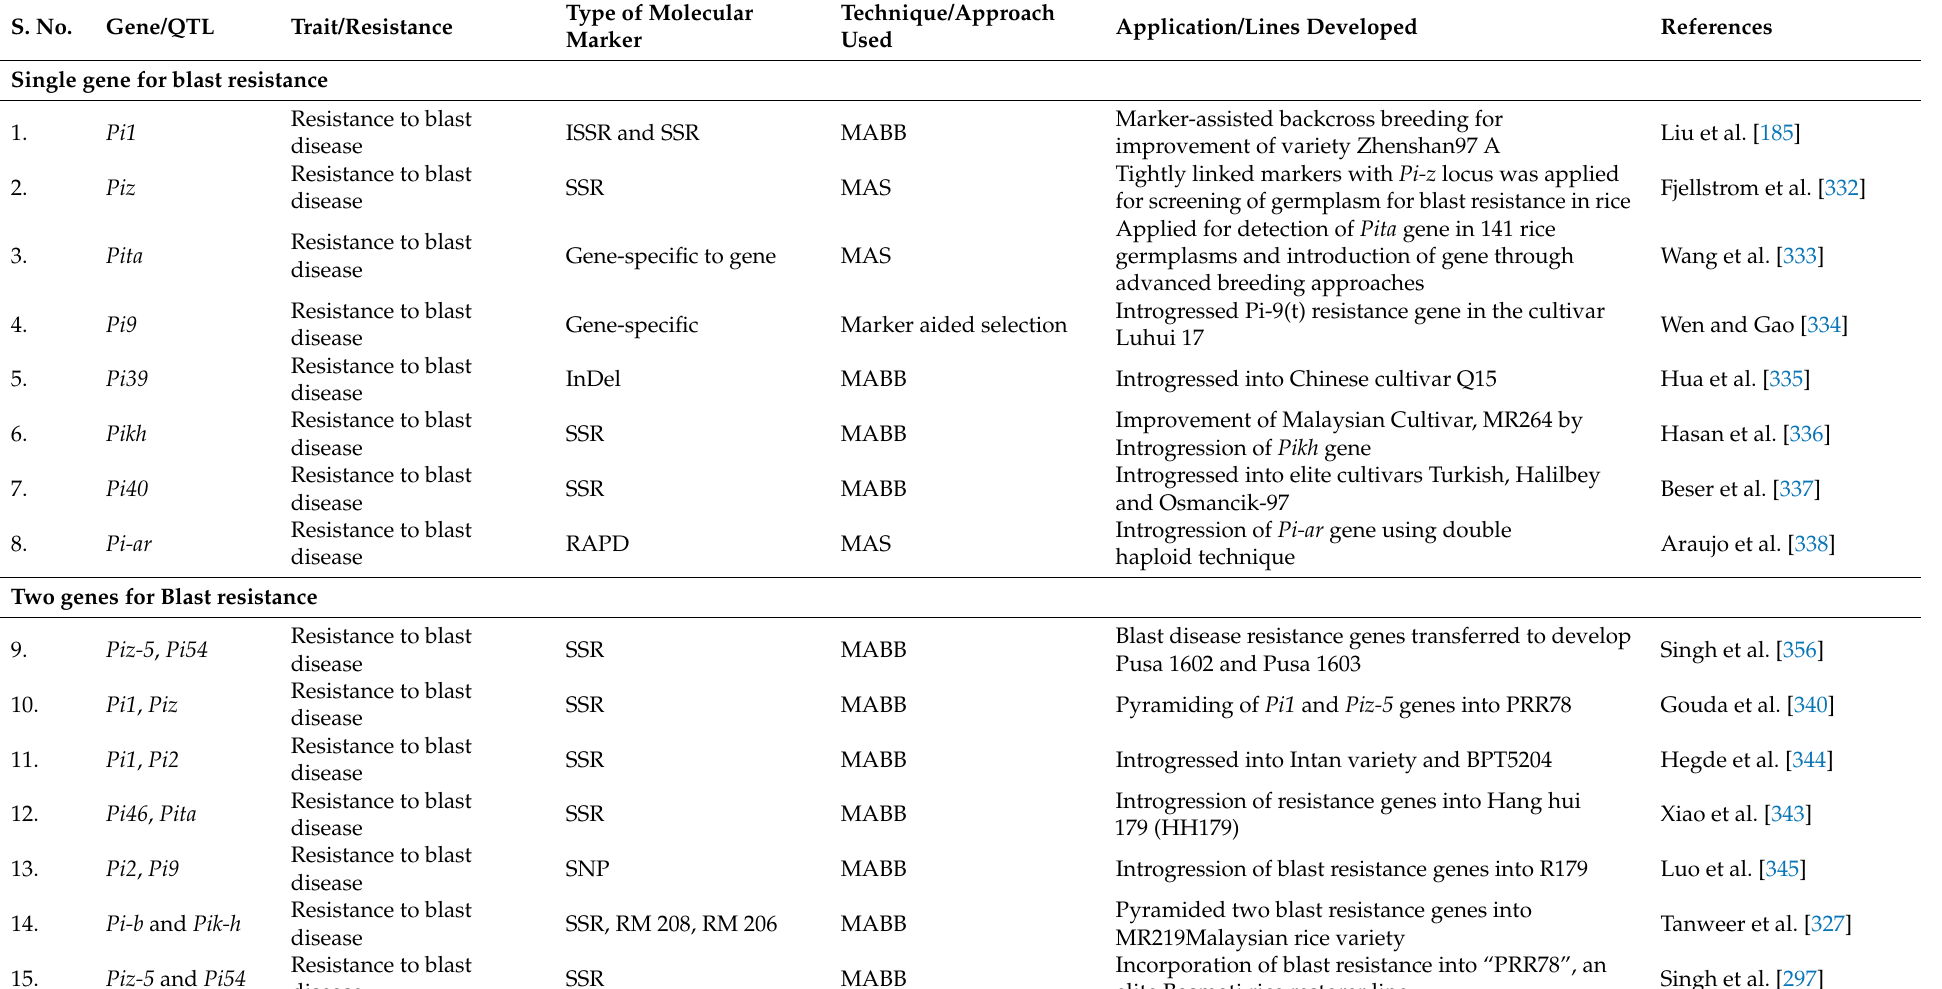
Table 4. List of blast resistance genes deployed for improvement of rice lines using marker-assisted selection (MAS) and marker-assisted backcross breeding (MABB). S.